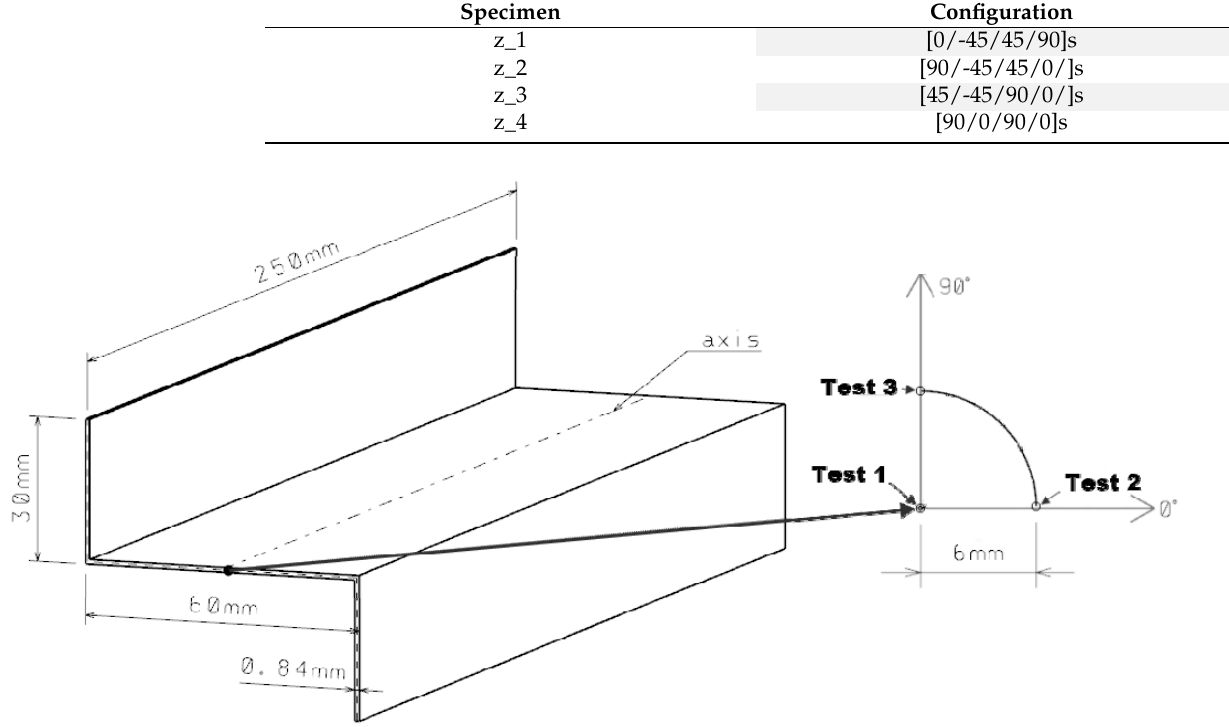
Figure 2. Geometrical Z-shaped column model with the schematic of the eccentricity load.